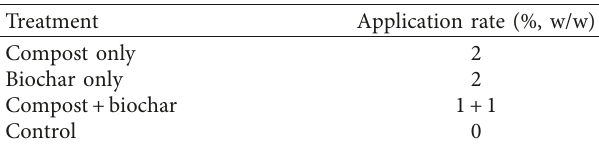
Table 3: Application rates (%) of biochar and compost used in the pot